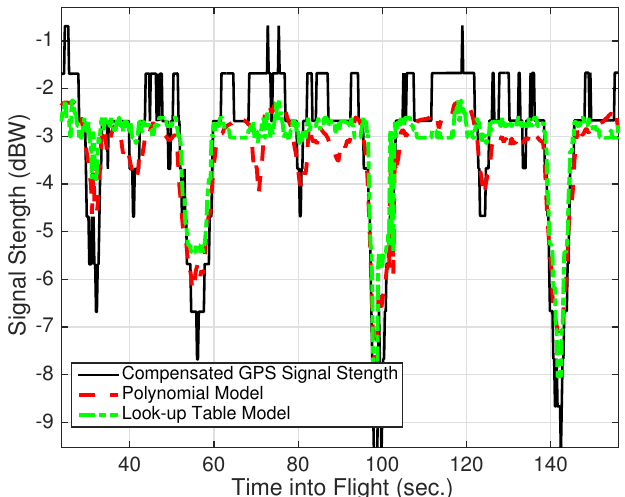
Figure 3. Example of calibration model for GPS PRN 6, which is at an elevation angle of 40° during this UAV